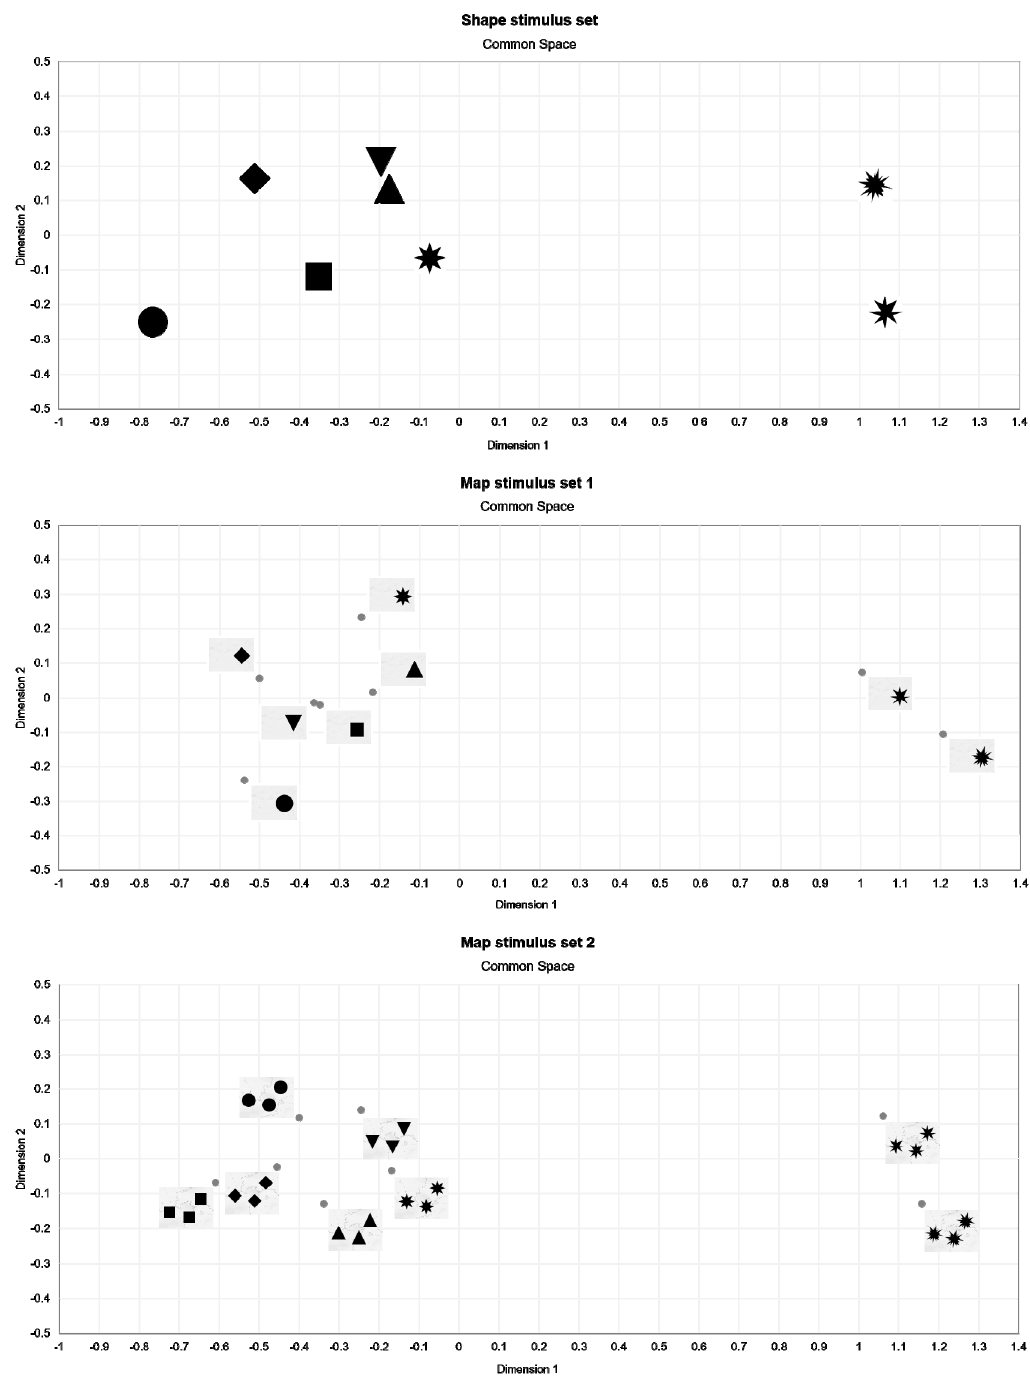
Figure 4. Two-dimensional configuration based on multidimensional scaling, indicating the proximities between the eight stimuli within each stimulus set.